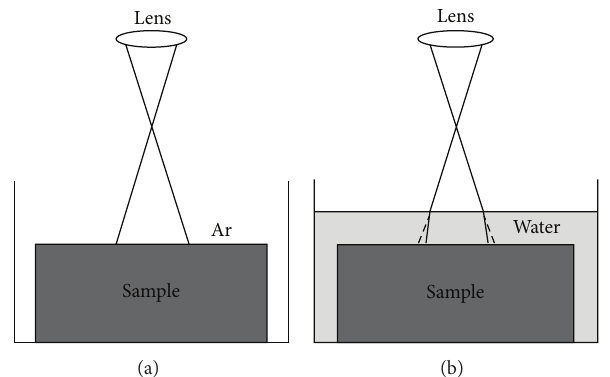
Figure 8: Schematic drawings of (a) straight beam at Ar environment and (b) refracted beam in underwater condition.